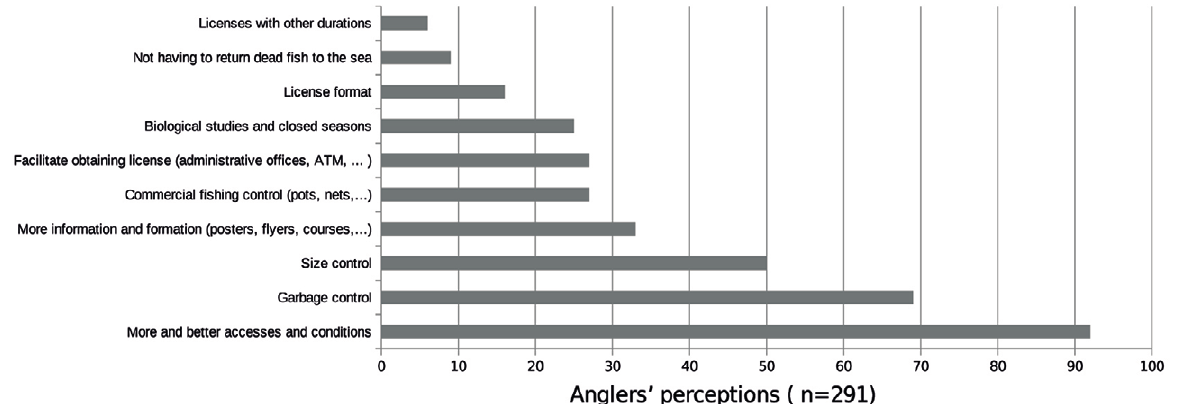
Fig. 3. – Anglers’ perceptions about recreational fisheries regulation and possible